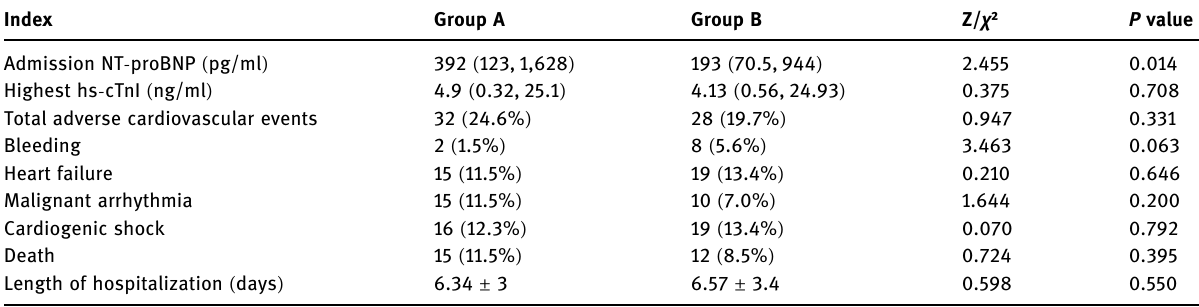
Table 4: Comparison of heart function parameters and adverse events between groups ( %, Q1, Q3 )